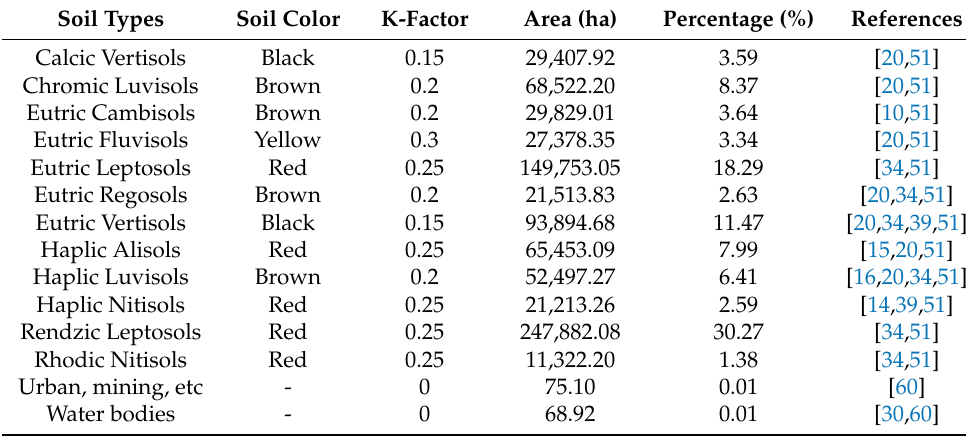
Table 3. Soil types, color, coverage and its K-factor.